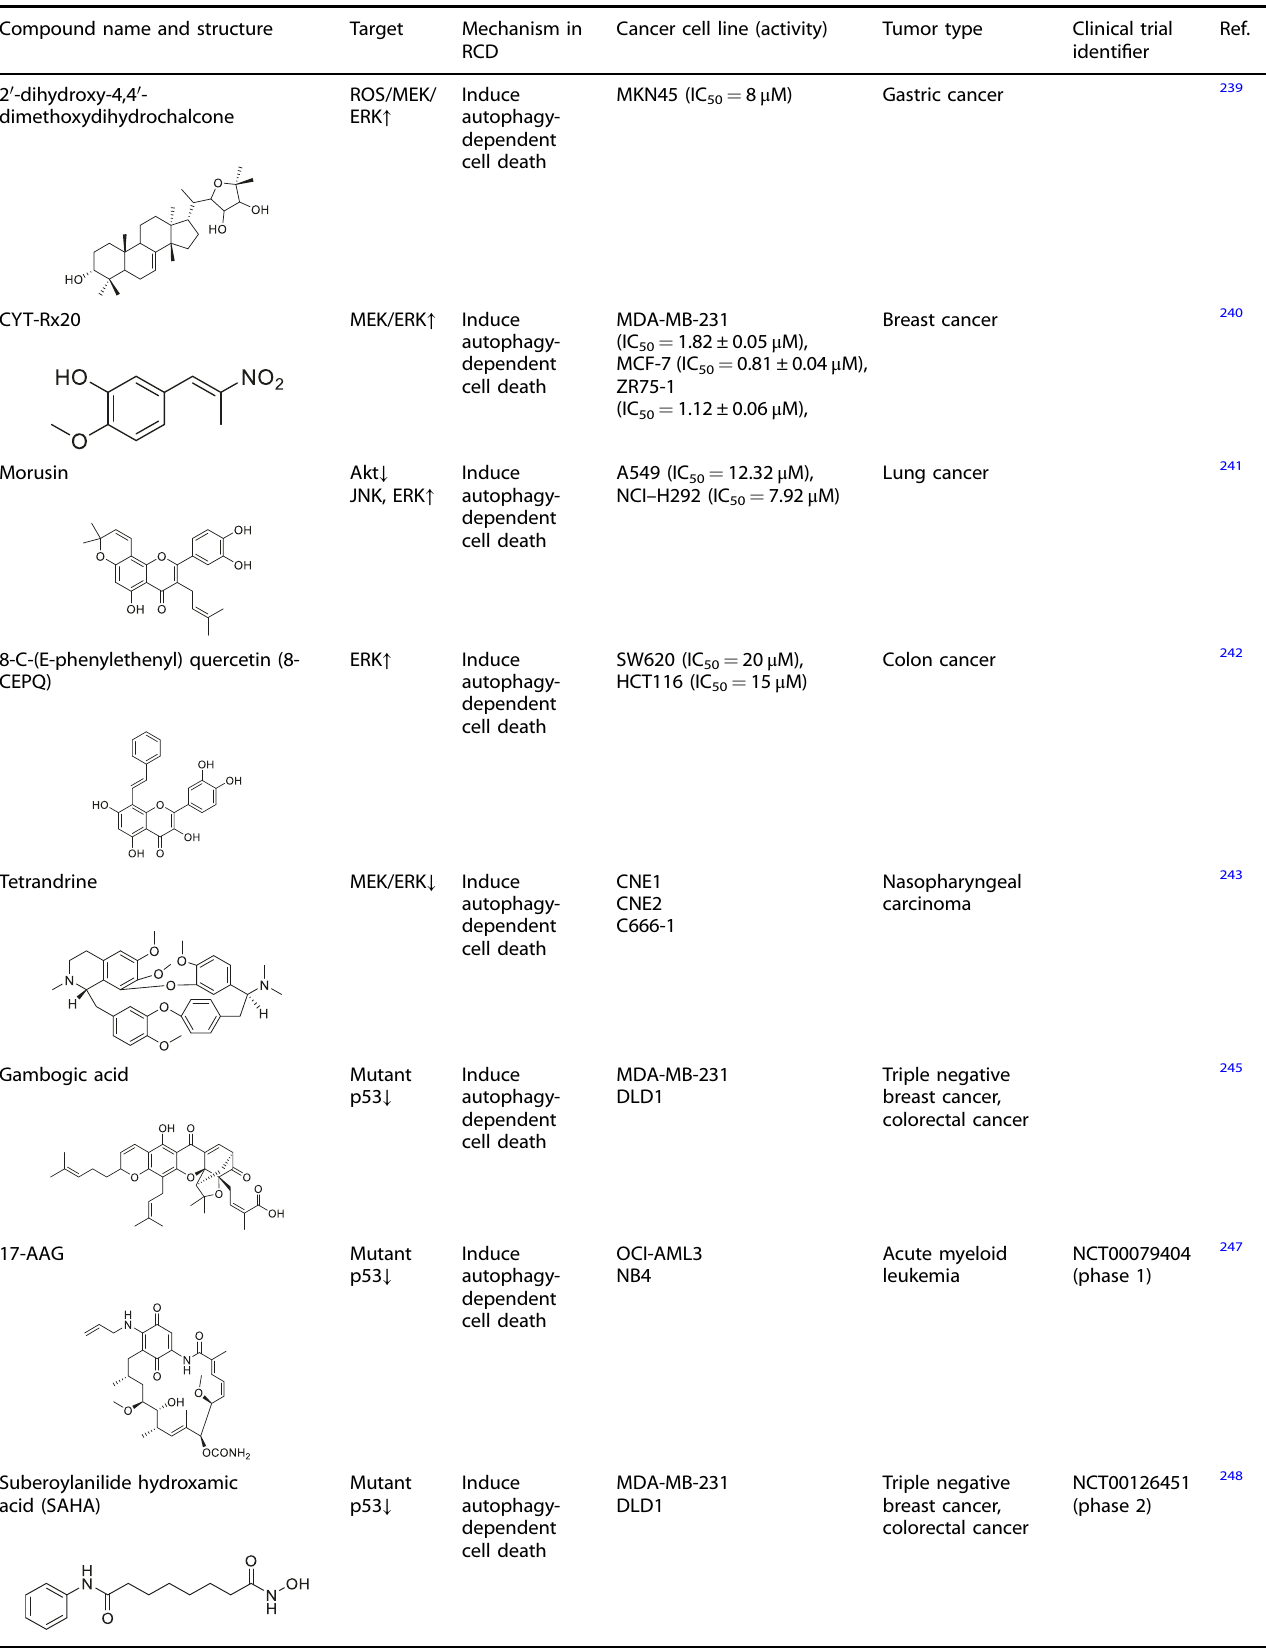
Table 8. Compounds targeting Ras/Raf/MAPKs, p53, p62, FoxO, and NF- κ B in cancer Compound name and